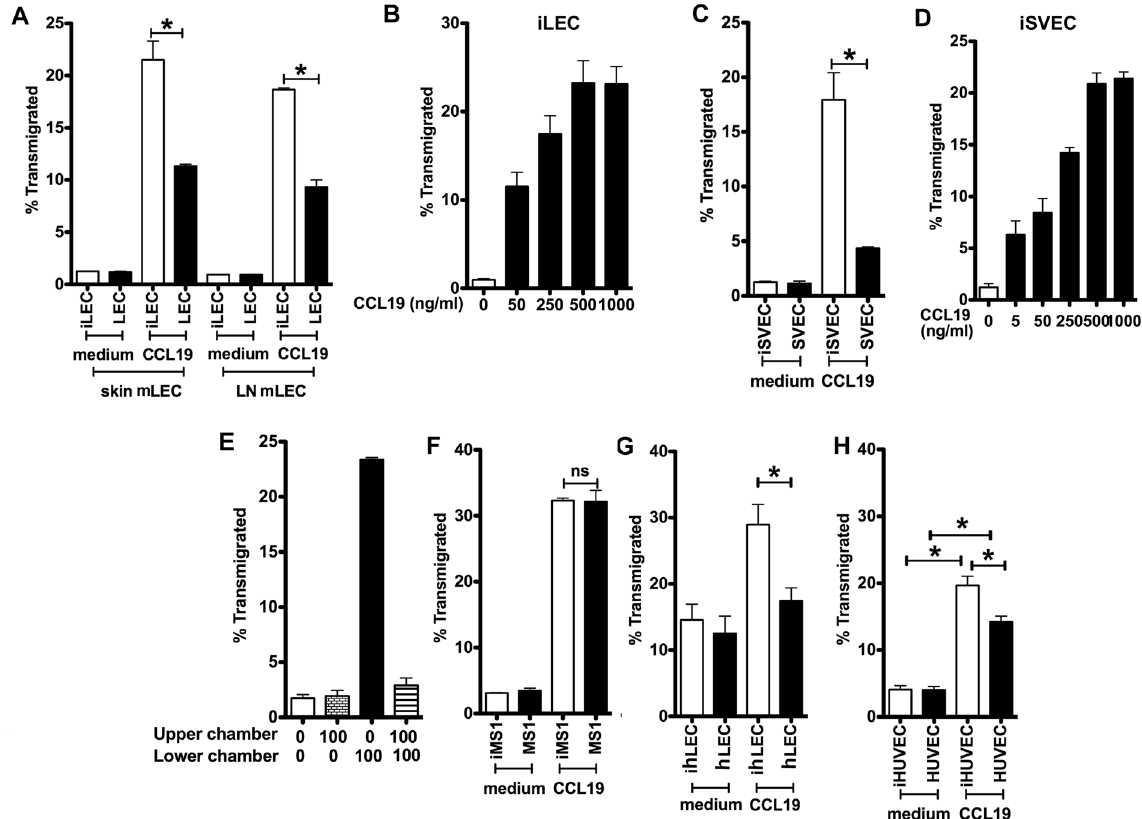
toward CCL19. ( D ) CD4 T cell migration across iSVEC4-10 toward various doses of CCL19. ( E ) CD4 T cell migration with CCL19 on upper, lower or both chambers across iSVEC. ( F ) CD4 T cell migration across iMS-1 or MS-1 toward CCL19. ( G , H ) Human CD4 T effector migration across ( G ) human primary hLEC or ihLEC layers toward CCL19, ( H ) Human CD4 T effector migration across HUVEC and ihLEC toward CCL19.